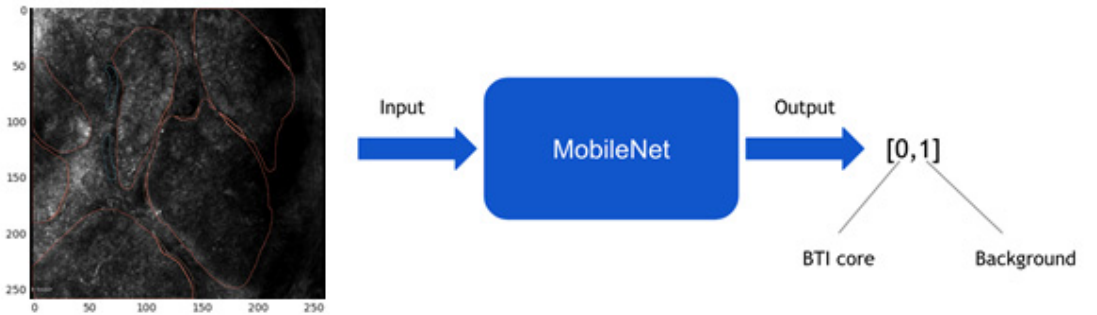
Figure 3. Training MobileNet: less than 50% of the patch area was annotated as malignant.